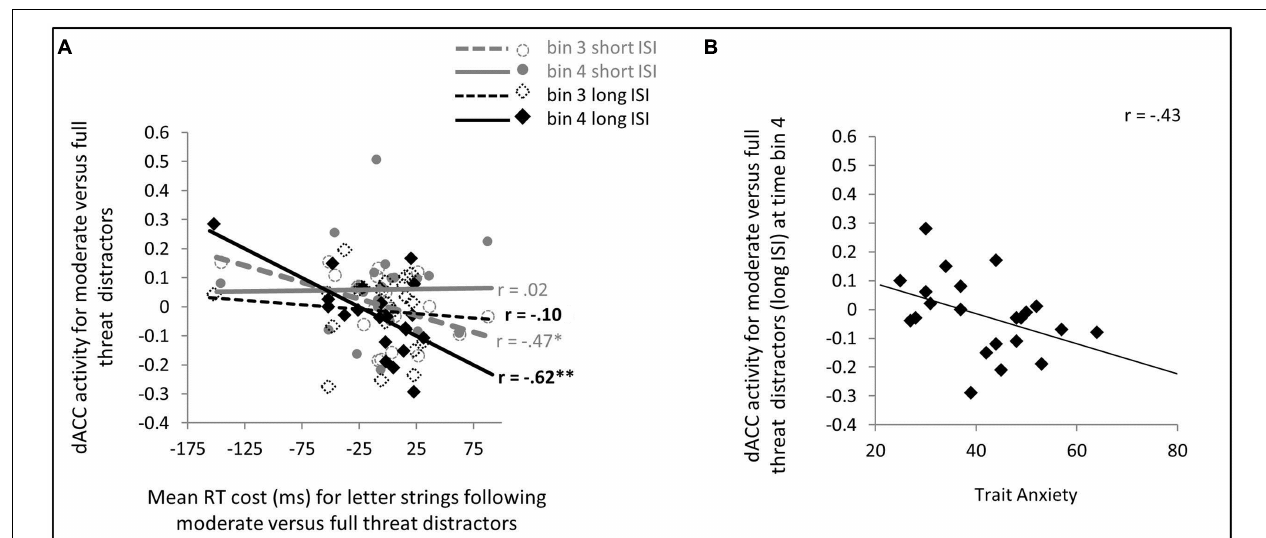
strong threat distractors, whereas no such relationship was observed for time bin 4 dACC activity.This relationship reversed for long distractor-target ISI trials, here time bin 4 dACC activity, but not time bin 3 dACC activity, was significantly linked to speed of letter target identification following moderate versus strong threat distractors. (B) On long distractor-target ISI trials, trait anxiety was negatively associated with dACC activity to moderate versus full threat distractors at a point (FIR time bin 4) when competition between ongoing face distractor representation and preparation for, or initiation of response to, letter targets was likely to be maximal. No parallel relationship was observed for short distractor-target ISI trials.